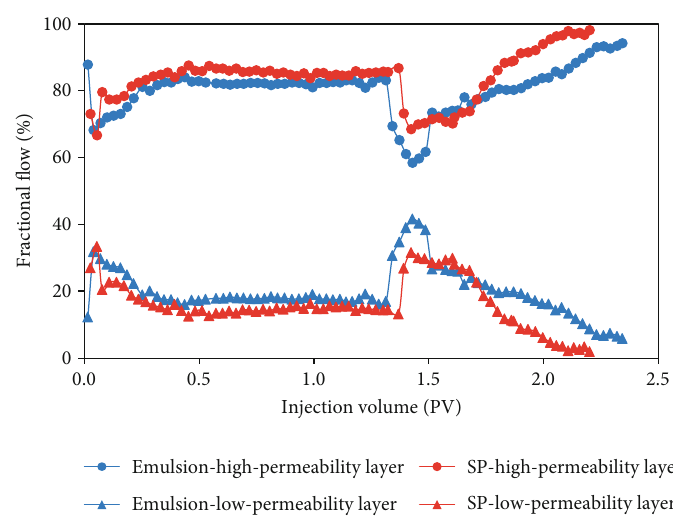
Figure 8: Fractional fl ow vs. injection amount in two experimental schemes.